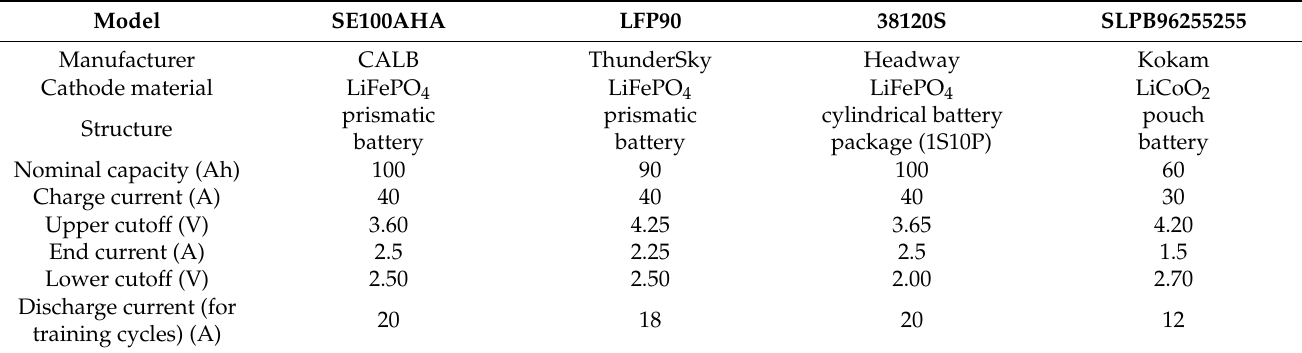
Table 1. Parameters of automotive-grade lithium-ion batteries used in the